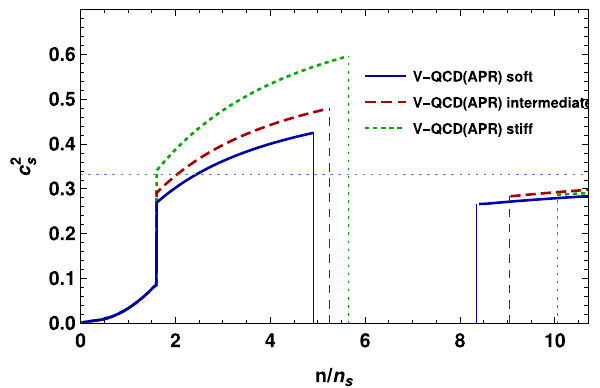
Fig. 16 Speed of sound for the three variants of hybrid V-QCD(APR)